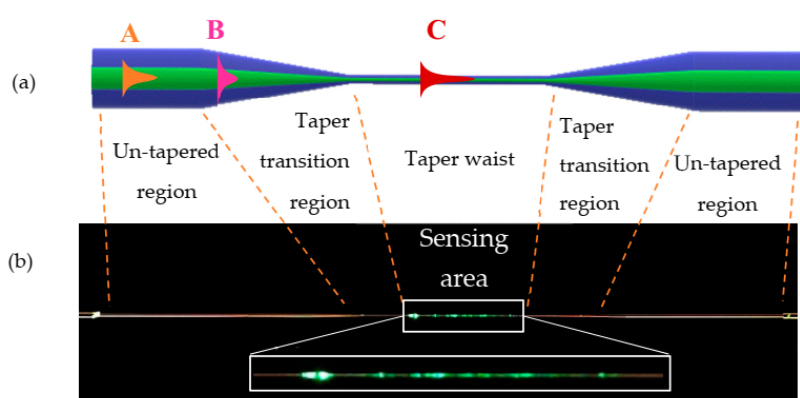
Figure 1. Scheme of ( a ) light propagation in di ff erent sections of the tapered fiber and ( b ) photo of a tapered optical fiber with a visible evanescent